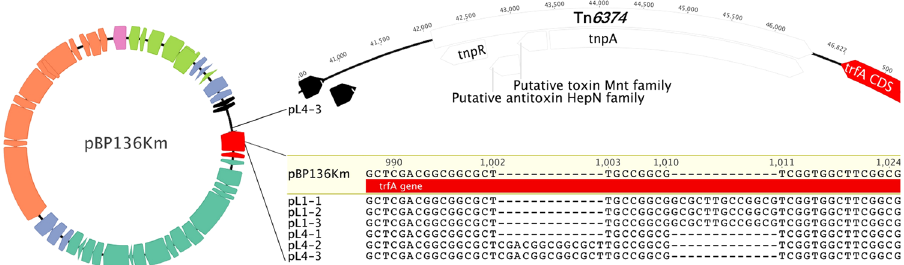
Figure 2. Map of plasmid pBP136Km, used in this study. Genes are highlighted by colors linked to their function: orange, conjugation; darker green, mating pair formation; red, replication; light blue, stable inheritance and partitioning; light green, regulation of plasmid functions; black, unknown function; pink, exogenous origin (inserted km resistance cassette). Top right shows the inserted transposon segment and its insertion location; bottom right shows the alignment of the 5 ′ - trfA region of the six plasmids to that of the ancestral